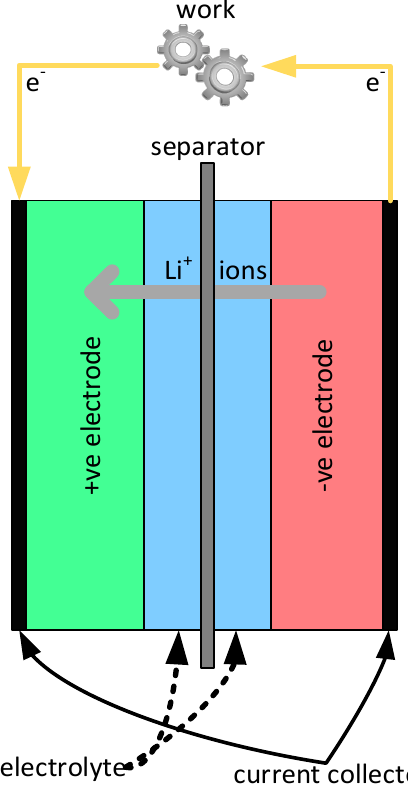
Figure 2. The schematic construction of a Li-ion battery showing the positive and negative electrodes, the electrode connecting electrolyte that includes a porous separator membrane intended to prevent direct contact between the two electrodes. When the battery acts as a galvanic device, the electrons travel from the negative electrode to a current collector to the load, and then via a second current collector to the positive electrode. Simultaneously, the Li + ions travel from the negative electrode through the electrolyte to the positive electrode to maintain electroneutrality.